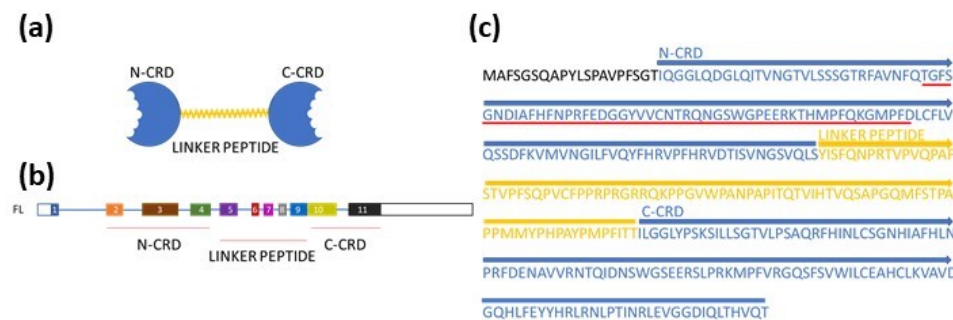
Figure 5. Detailed protein structure of full-length (FL) GAL-9. ( a ) FL protein contains N-terminal CRD (N-CRD) and C-terminal CRD (C-CRD) linked by a linker peptide. N-CRD is encoded by exons 2, 3 and 4 ( b ) and contains 123 AAs ( c ). Linker peptides composed of 87 AAs are encoded by exons 5–9. Exons 10–11 encode the C-CRD, which is composed of 125 AAs. The commercially available anti-GAL-9 antibody used in this study was obtained by immunization with recombinant oligopeptide whose primary structure is underlined in red.